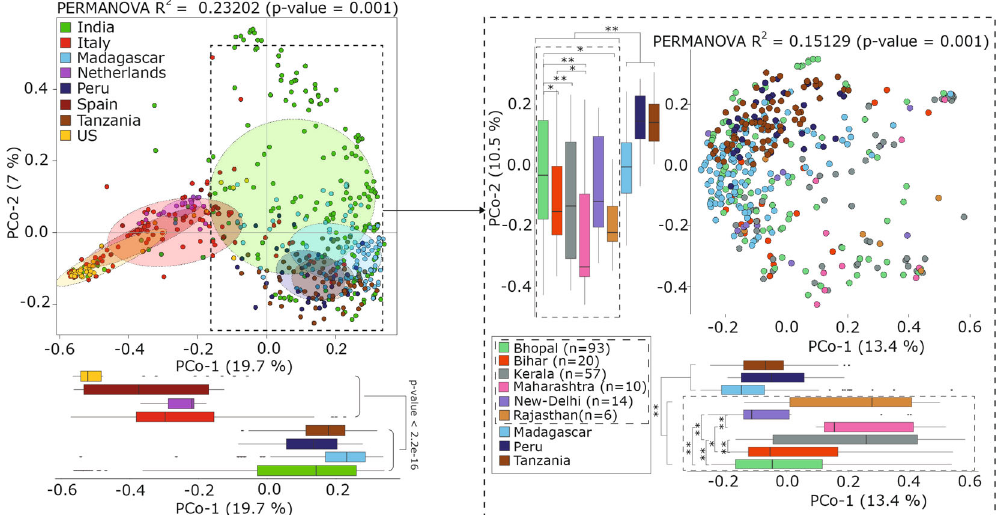
Fig. 2 Inter-sample variation of human gut microbiome samples based on Prevotella composition. Principal coordinates analysis (PCoA) considering inter-sample Bray – Curtis distance based on the relative abundance of genomes/bins belong to Prevotella genus in each population. The PCoA plot represented in dashed rectangle further shows the distribution of samples from different geographical regions in India with samples from non-western populations. A nonparametric two-sided Wilcoxon rank-sum test was used for testing the box-plot distributions. ns refers to “ not signi fi cant ” , * indicates p -value < 0.05 and ** indicates p -value < 0.01. The whiskers, bound of the box, and the line in the middle of the box represent the min-to-max values, 25th – 75th percentiles, and median,